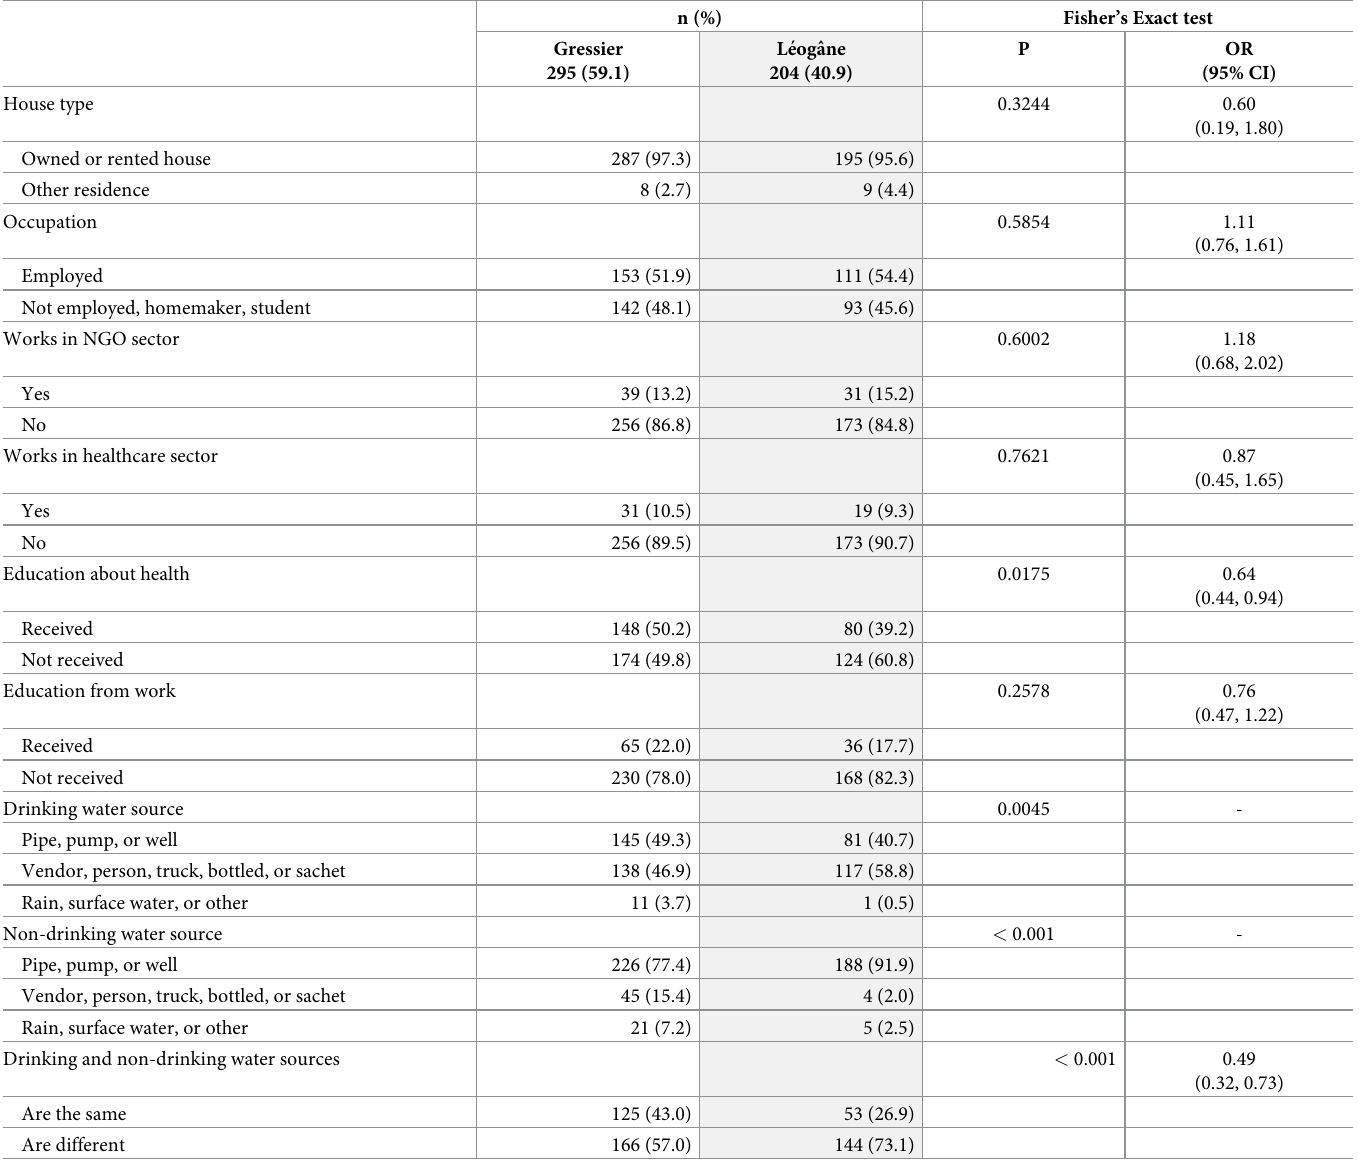
Table 1. Comparison of participant characteristics (Fisher’s Exact